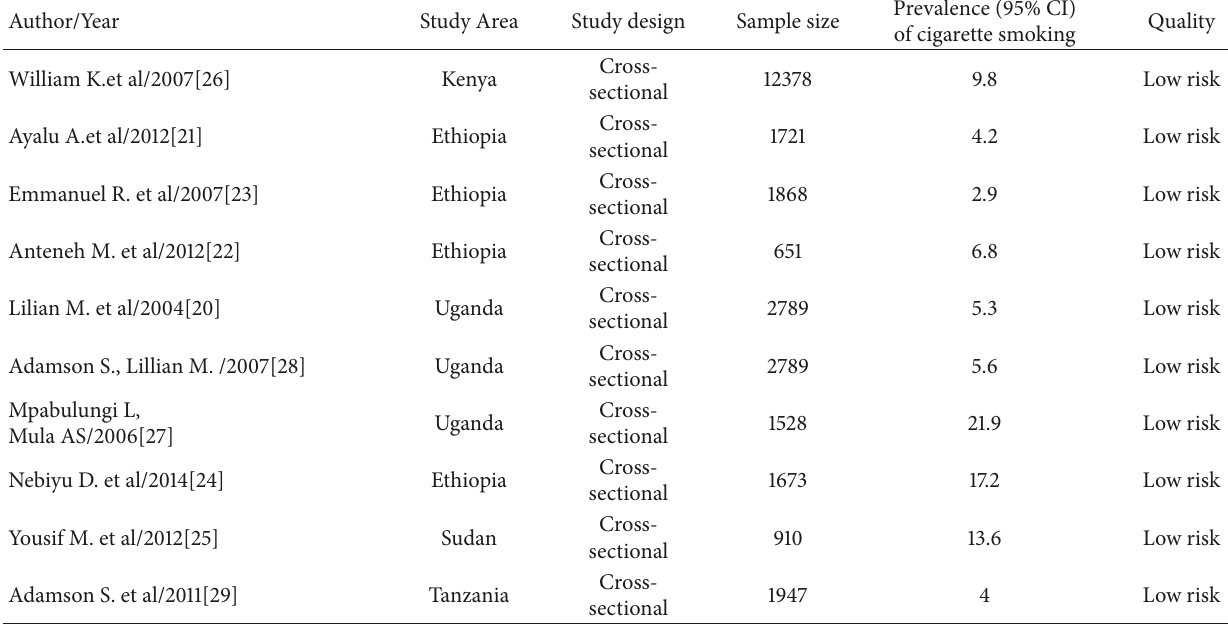
Table 1: Characteristics of systemic review and meta-analysis articles (n=10).